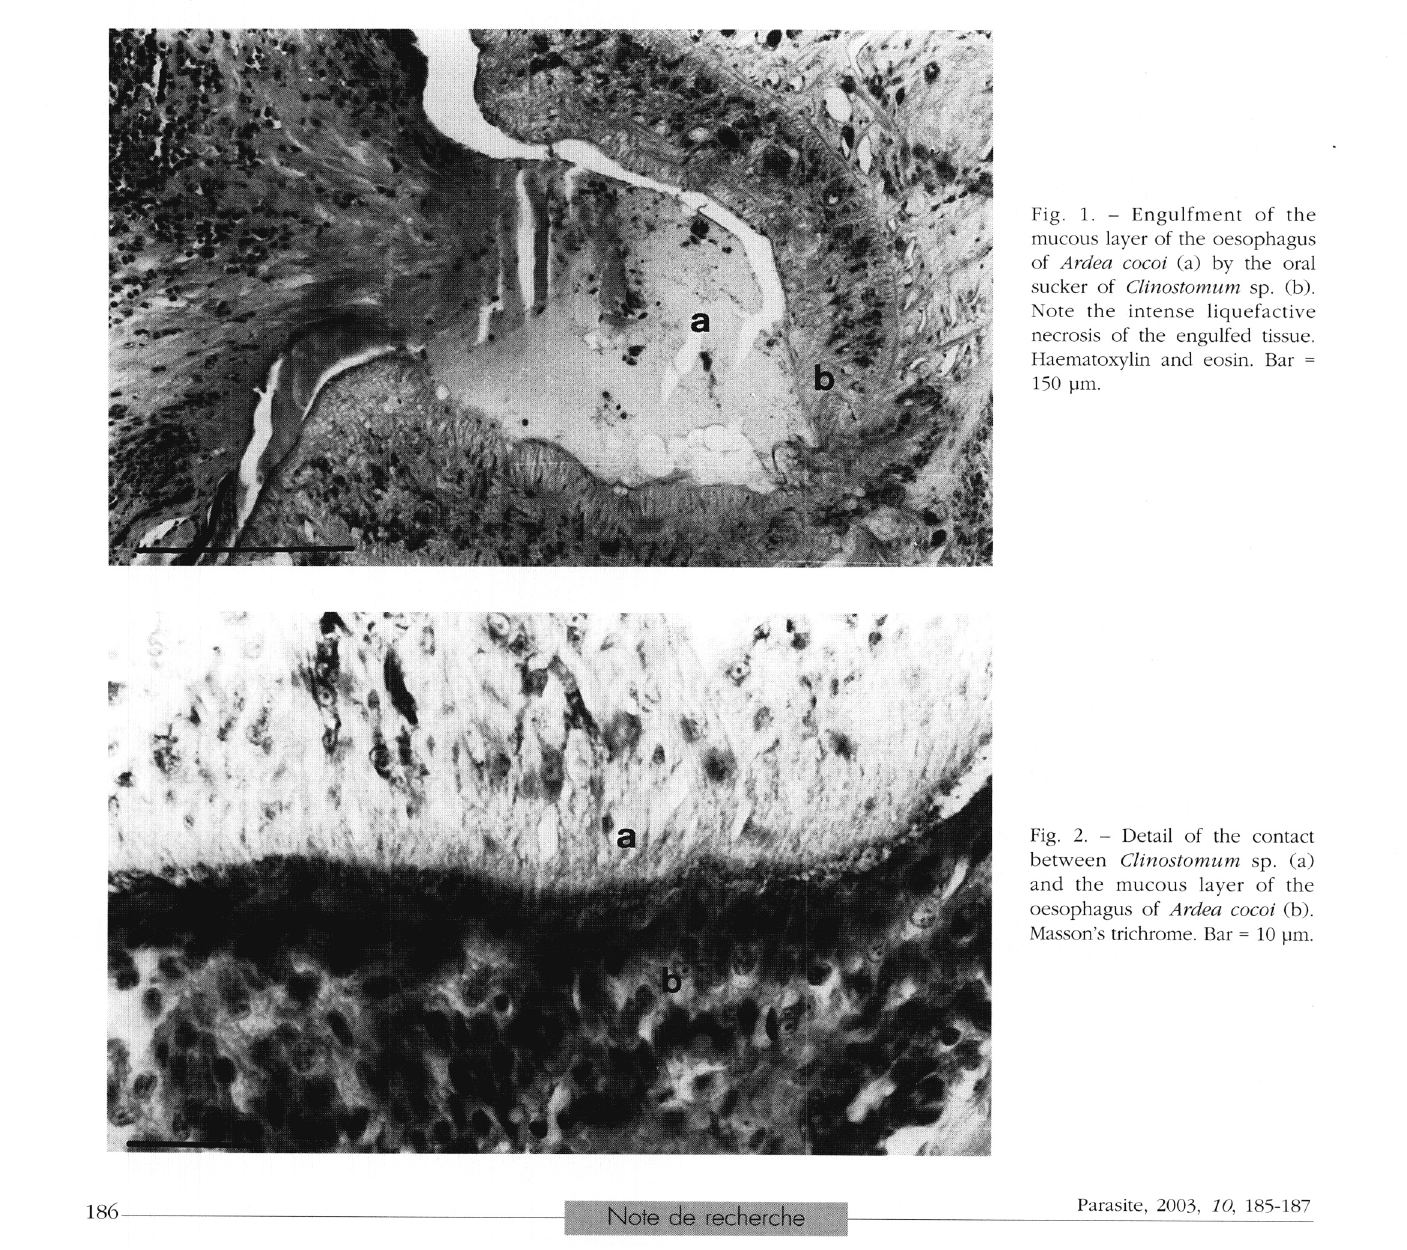
Fig. 2. - Detail of the contact between Clinostomum sp. (a) and the mucous layer of the oesophagus of Ardea cocoi (b). Masson’s trichrome. Bar = 10